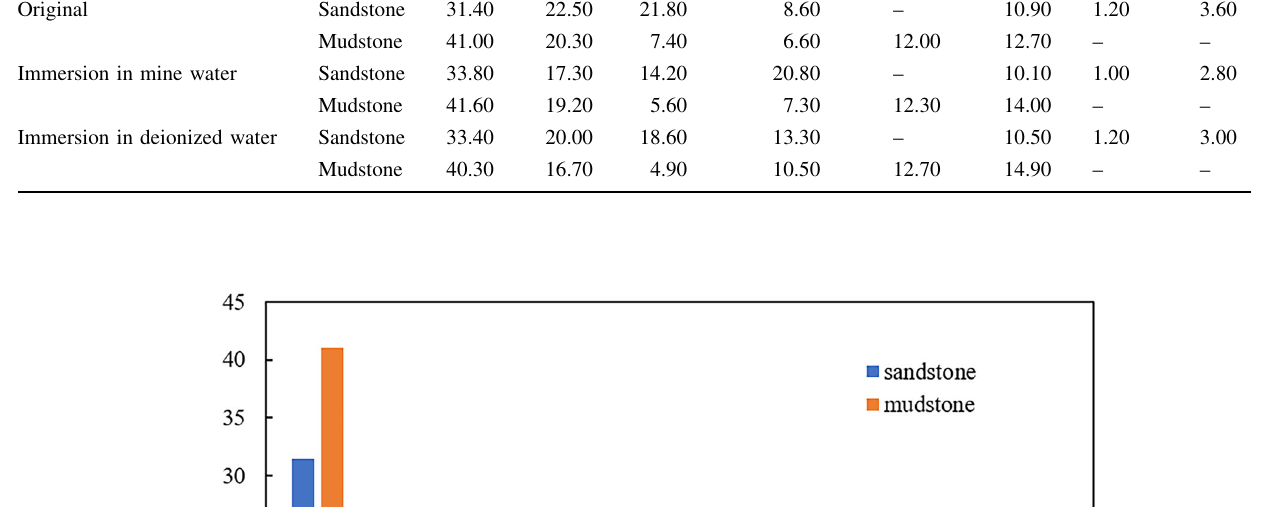
Fig. 6 Analysis of mineral composition of rock samples Table 3 Mineral composition and content of fine sandstone (%) Item